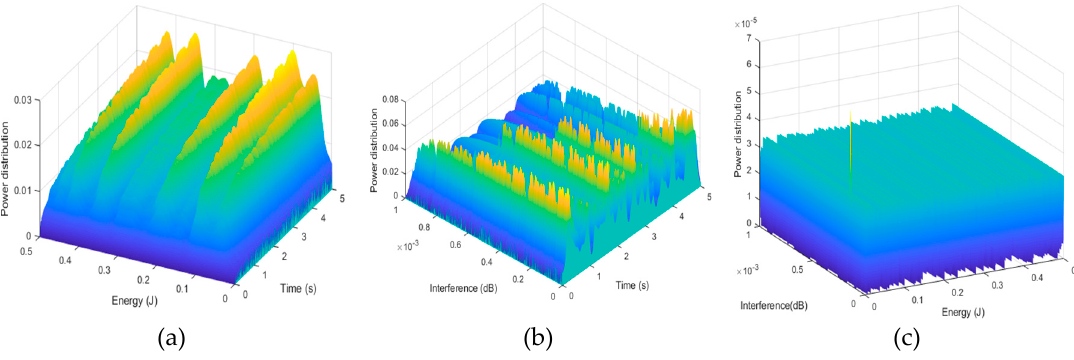
Figure 5. Power distributions for respective scenarios (a) β max = 6 x 10 -6 W, (b) E max = 0.5 J, (c) T = 5 s.